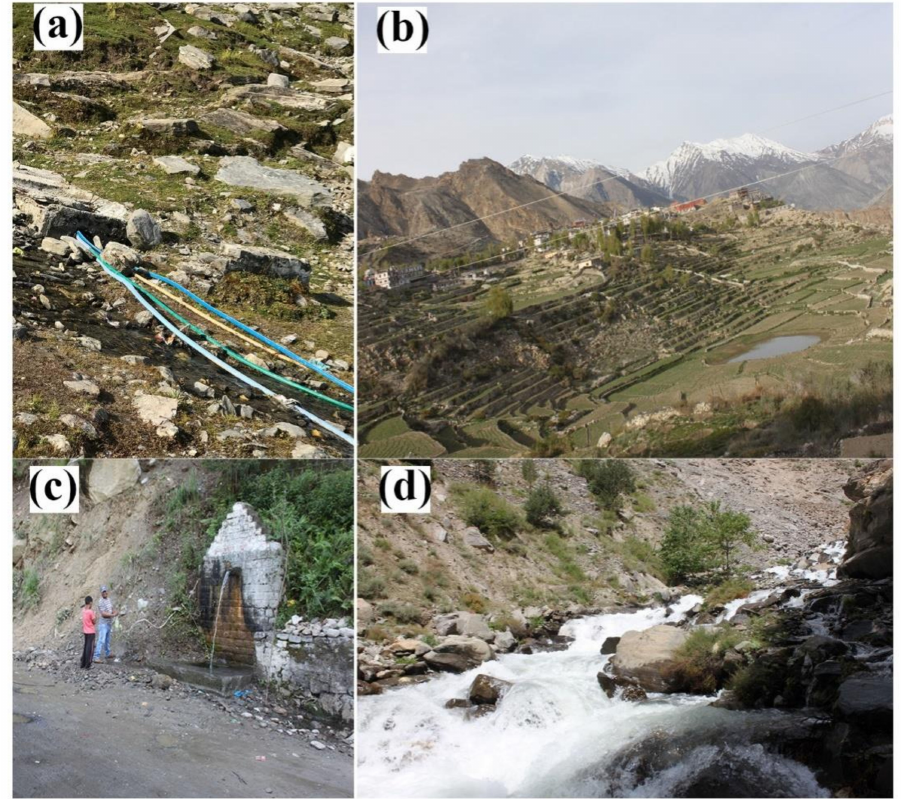
Figure 9. Photographs tell the importance of springs in the daily lives of people living in higher altitudes within Himachal Pradesh in the Indian Himalayas: ( a ) near Rohtang Pass of Kullu districts at 3100 m elevations of Beas basin, water from spring used for household purpose; ( b ) Nako village of Kinnaur districts of Satluj basin at 3200 m elevations, harvested water from spring for horticulture; ( c ) on the way to Bharmour, Chamba at 1500 m elevation, spring water has been used by tourist and local people of the Ravi basin; ( d ) natural spring within the Satluj basin of Kinnaur districts. All photographs were taken during our primary